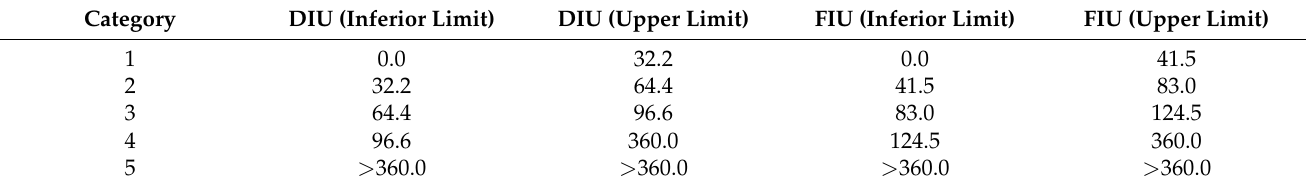
Table 7. Limits for DIU and FIU by category in Colombia for the year 2020.